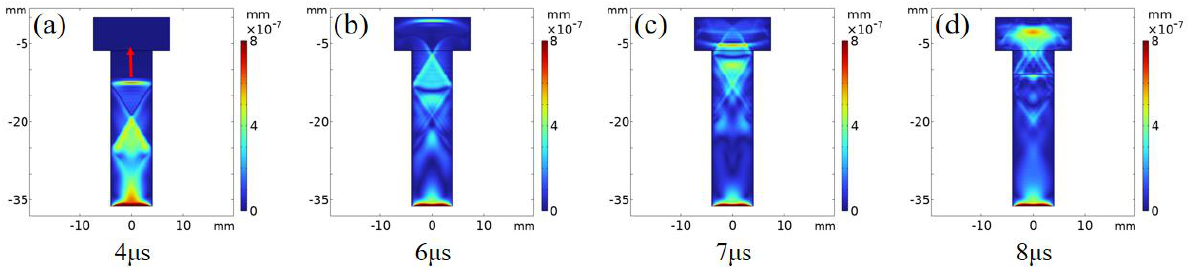
Figure 5. Displacement of the mechanical vibration caused by thermo − elastic effects in the bolt; dissemination process: ( a ) → ( b ) → ( c ) → ( d ).